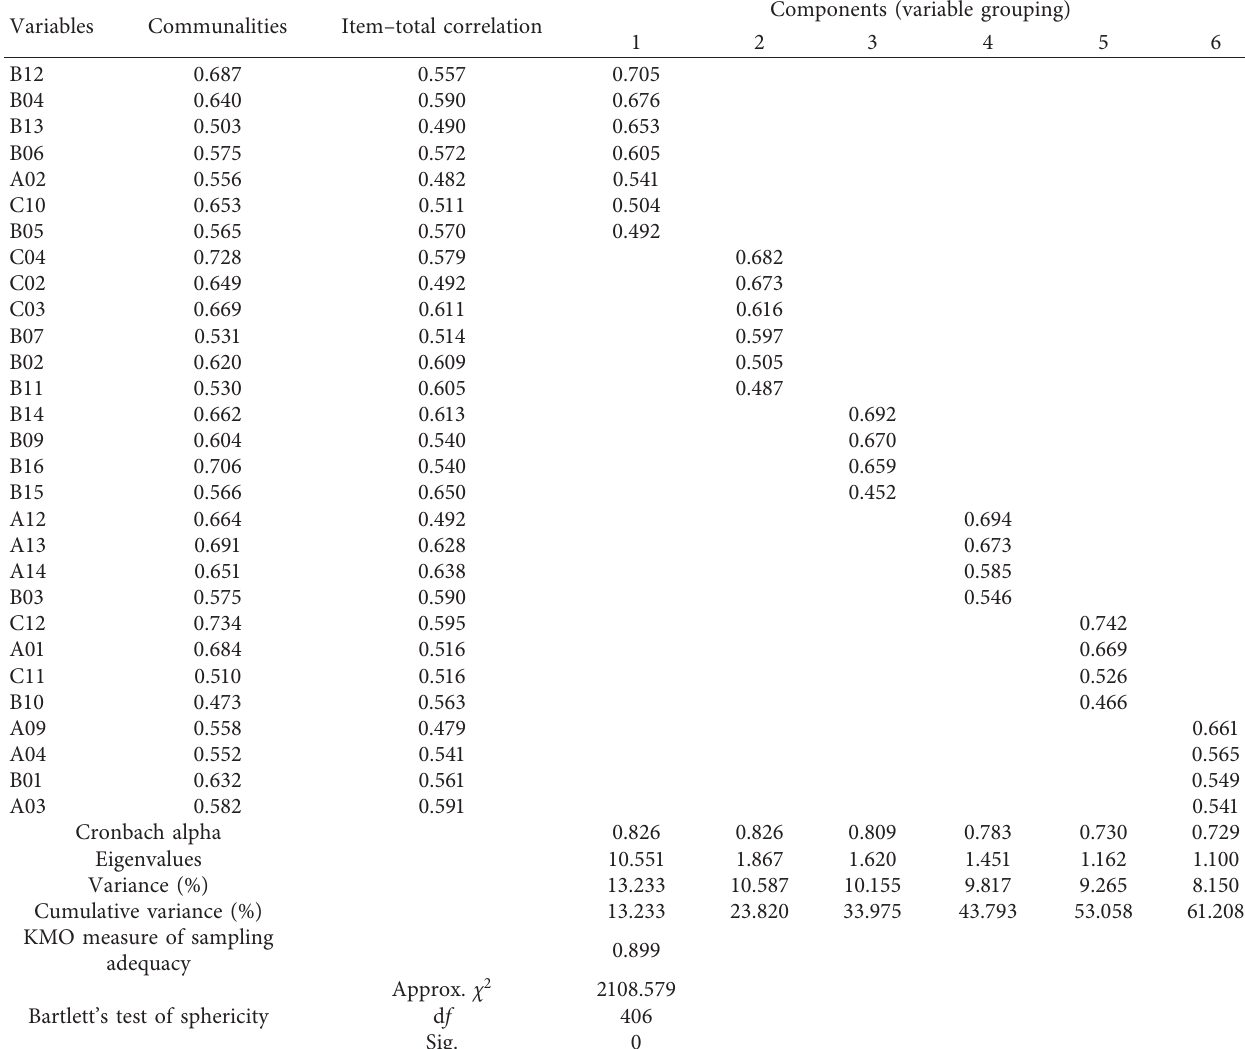
Table 5: Results of the factor analysis for the internal